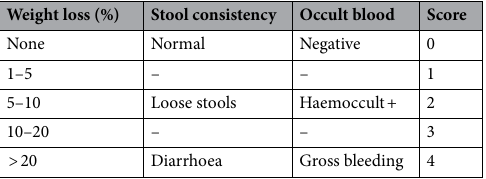
Table 1. Disease activity index